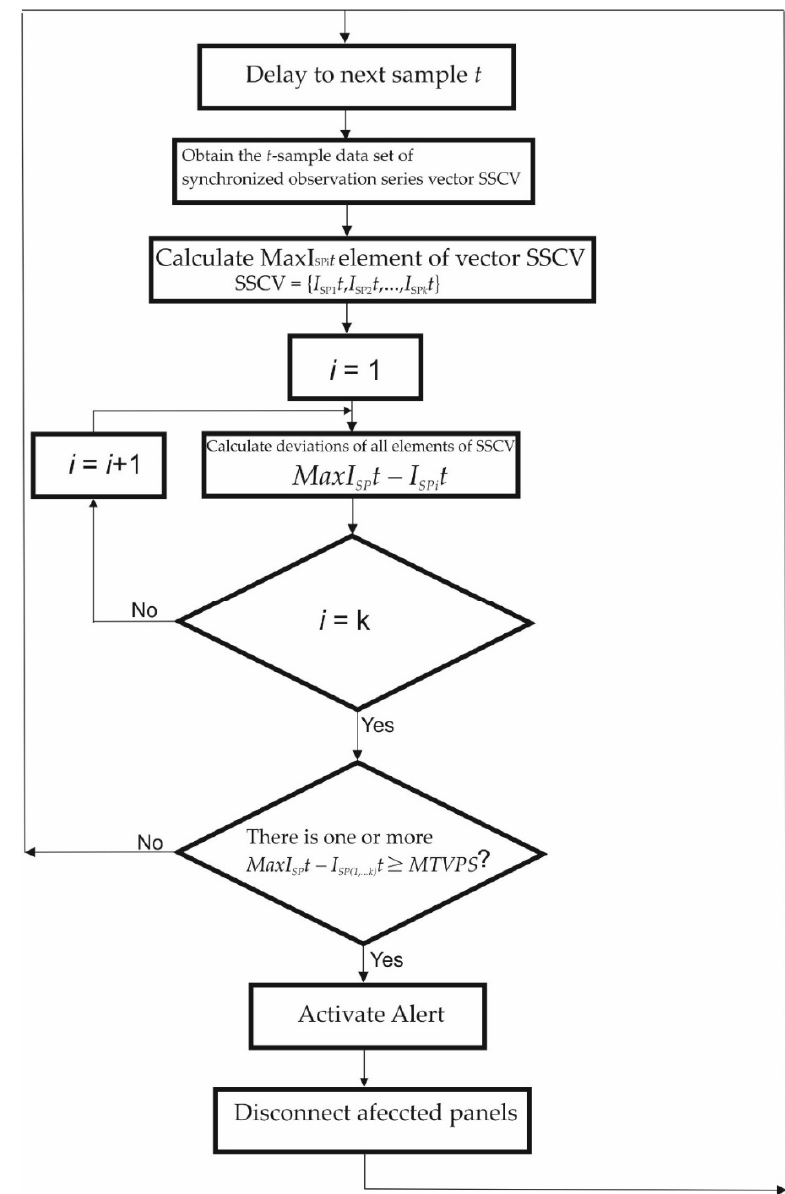
Figure 9. Online deviation trend comparative analysis algorithm, flow chart.